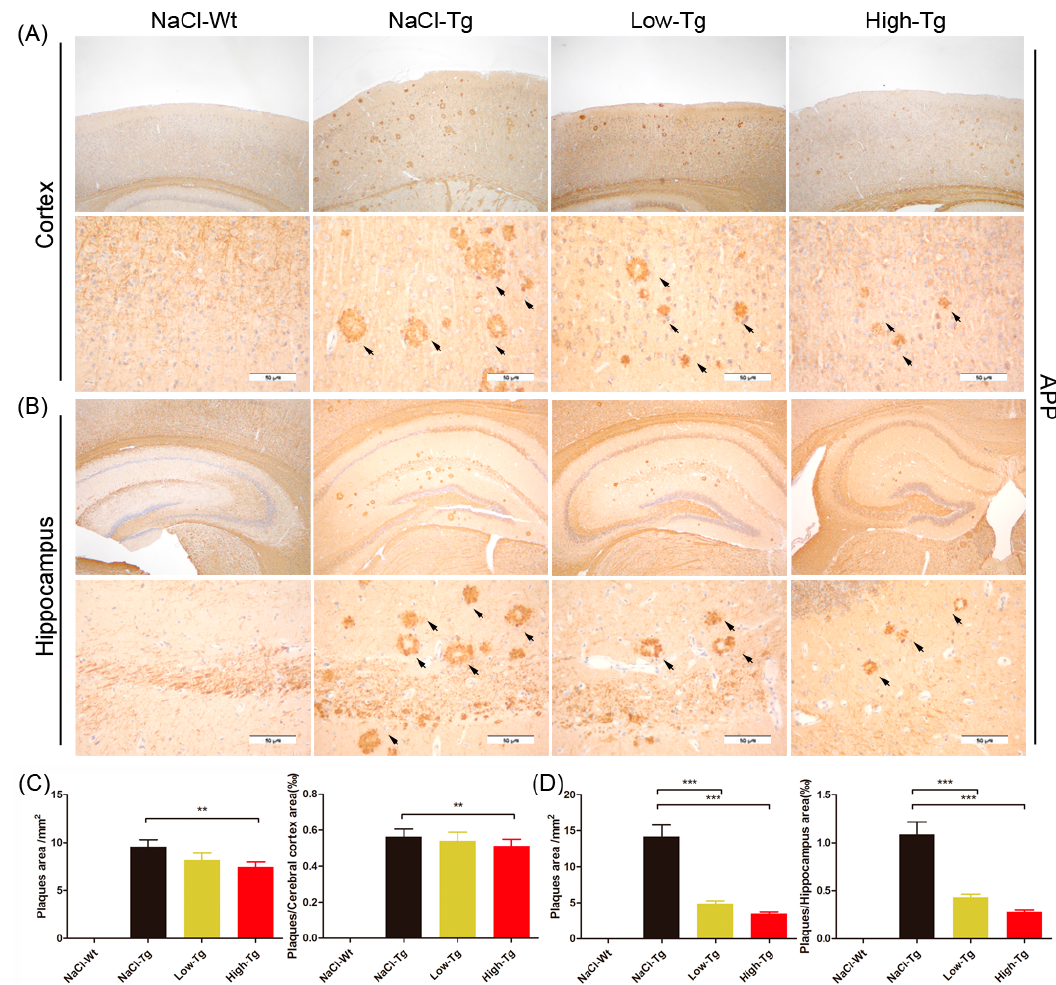
Figure 4. Immunohistochemical (IHC) analysis of amyloid plaque deposits in the cortical and hippocampal section of APPswe/PSEN1dE9 mice treated with DhHP-6. ( A , B ) Representative IHC photomicrographs of amyloid plaques (at the arrowhead) in the cerebral cortex and hippocampus of APPswe/PSEN1dE9 mice, scale bar = 50 μ m. Amyloid plaque area in the cerebral cortex (** p < 0.01, C ) and hippocampus (*** p < 0.001, D ) of APP/PS1 mice. Astrocytes are abundant and heterogeneous glial cells that accumulate extensively at sites of A β deposition [44]. A dense mass of GFAP+ cells with apparent atrophy, smaller cell bodies, and fewer and shorter processes were seen around the A β plaques of NaCl-Tg mice. In contrast, the astrocytes of NaCl-Wt mice had normal morphology, dispersed uniformity, and longer processes. The active astrocytes in the Low-Tg and High-Tg mice showed improvement with more and longer processes compared to the NaCl-Tg mice, both in the cortex (length of dendrites in Low-Tg, * p < 0.05 and High-